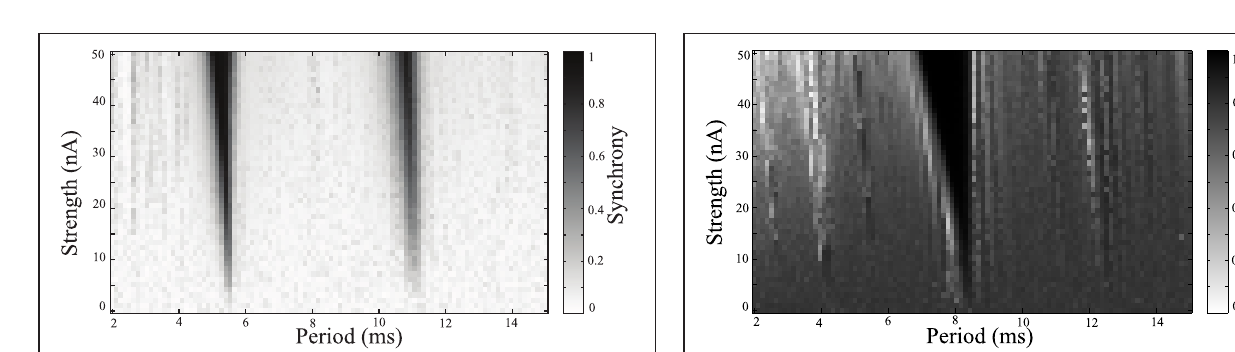
Frontiers in Neural